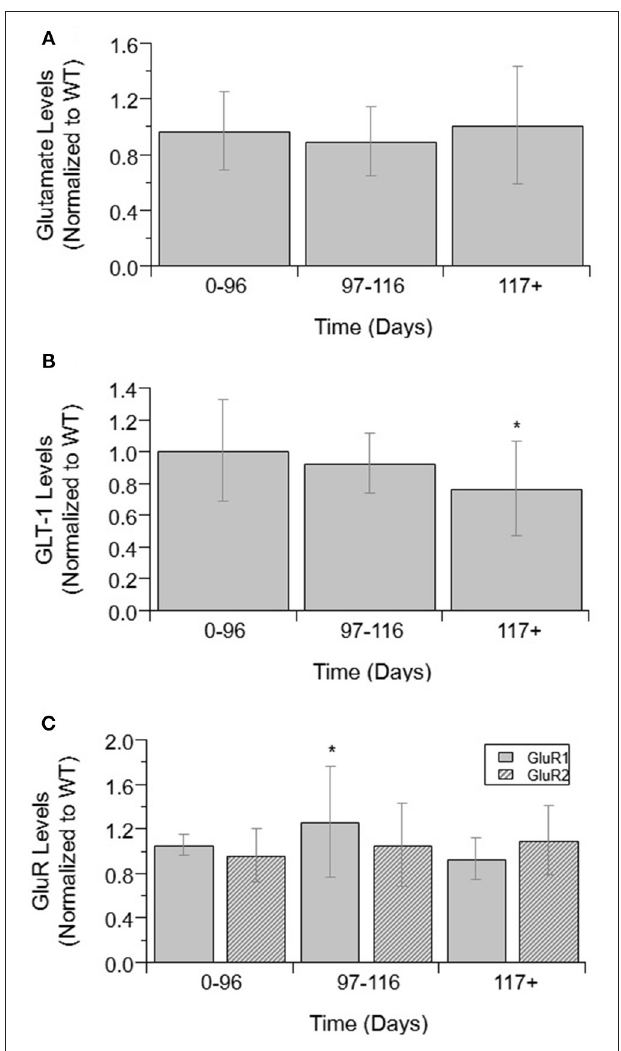
FIGURE 1 | Glutamate, GLT-1, and GluR complex levels in mixed cultures over ALS disease progression . (A) Glutamate level average in SOD1-G93A mice normalized to wild-type (ratio presented as SOD1-G93A/WT) in three temporal stages: 0–96 days, 97–116 days, and 117 + days. There was no significant change in glutamate levels between any of the temporal stages. (B) GLT-1 average in SOD1-G93A normalized to wild-type (ratio presented as SOD1-G93A/WT) in three temporal stages: 0–96 days, 97–116 days, and 117 + days. GLT-1 is significantly decreased from WT (* p = 0.0075) at 117 + days. (C) GluR1 (solid bars) and GluR2 (stripped bars) average in SOD1-G93A normalized to wild-type (ratio presented as SOD1-G93A/WT) in three temporal stages: 0–96 days, 97–116 days, and 117 + days. There was no significant change in GluR2 levels between temporal stages. GluR1 at 117 + days was significantly decreased from 0–96 (* p = 0.0346). Error bars represent SD.